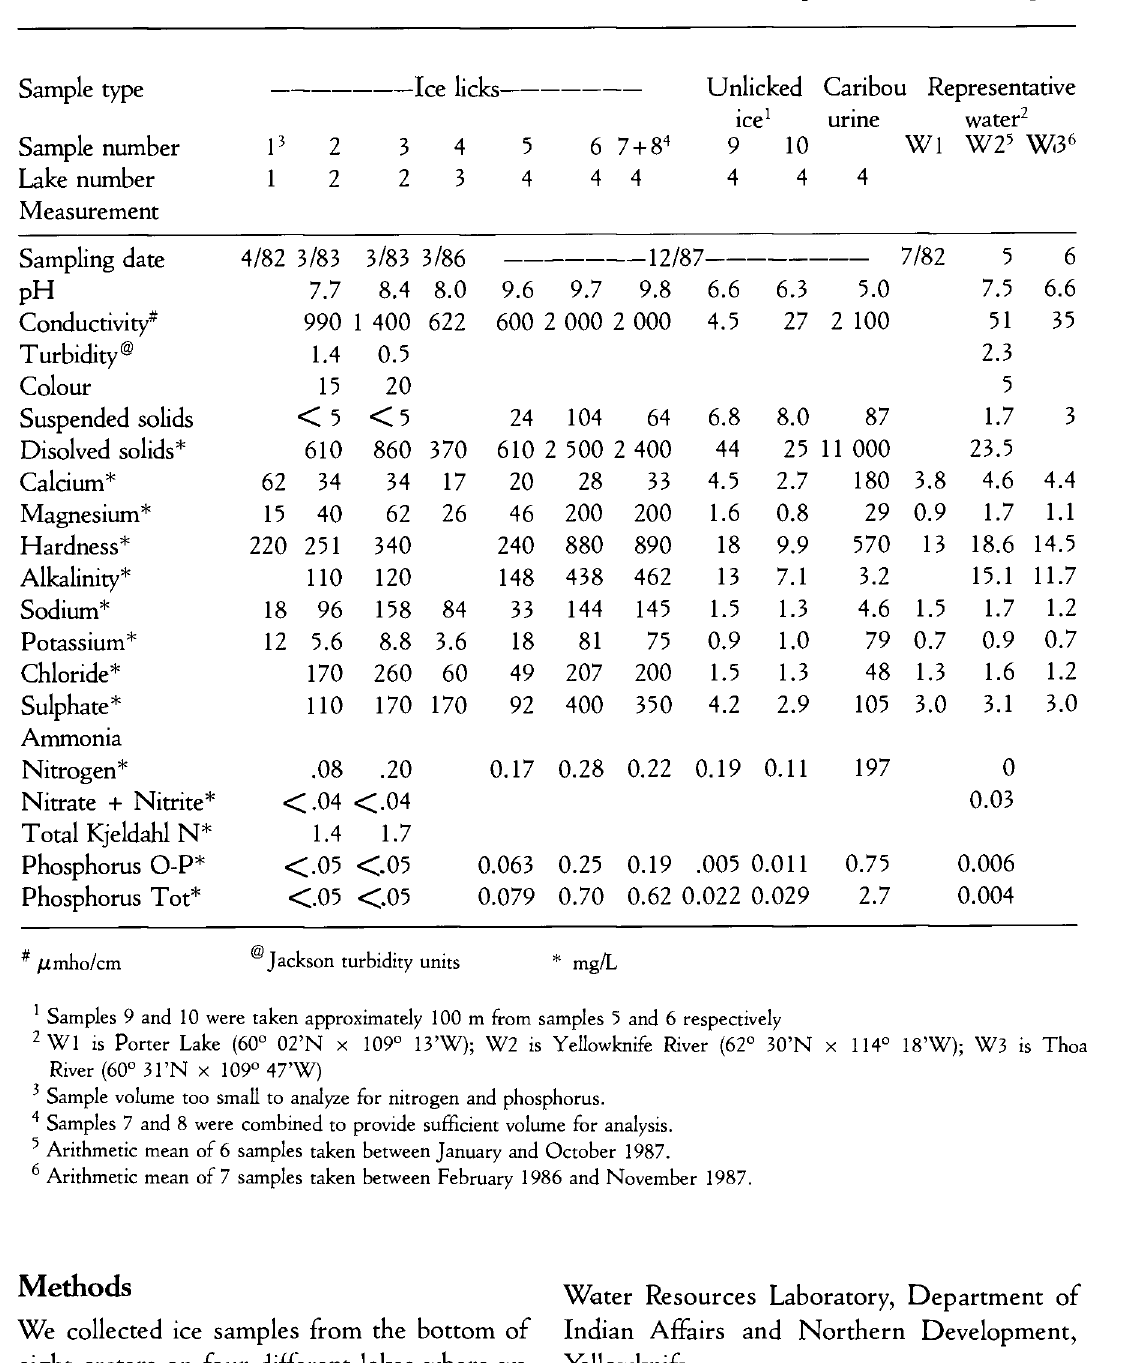
Table 1. Mineral concentrations in ice licks, unlicked ice, caribou urine and representative water